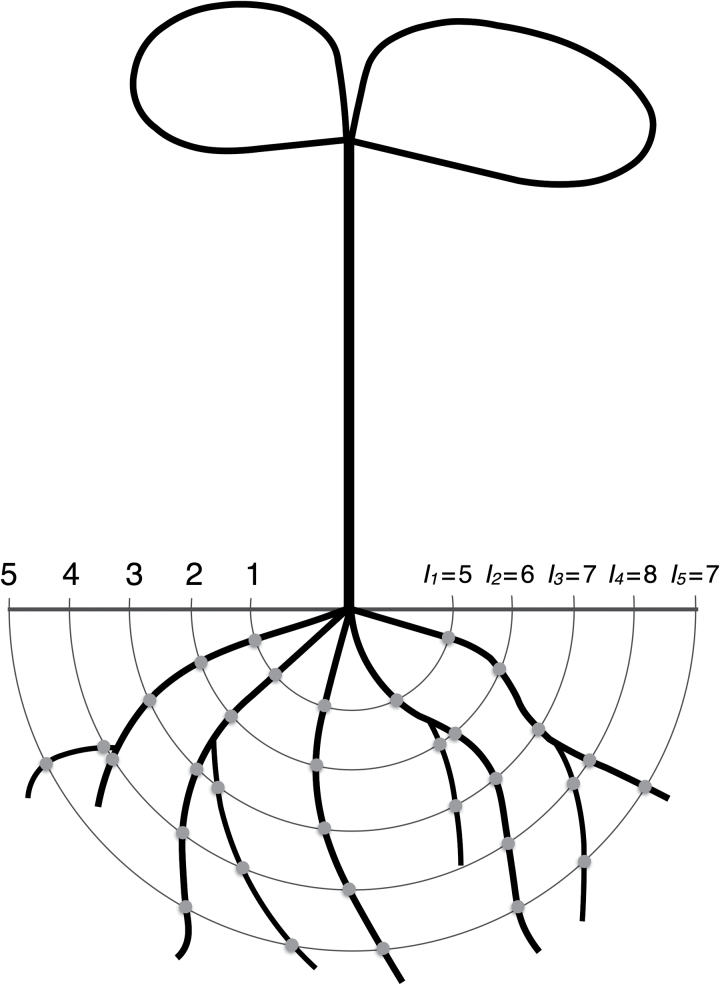
Principle of root phenotyping by Sholl analysis, in which concentric circles are drawn at regular intervals around the root origin and the number of root-circle intersections was counted for each circle (this figure is available in colour at JXB online).